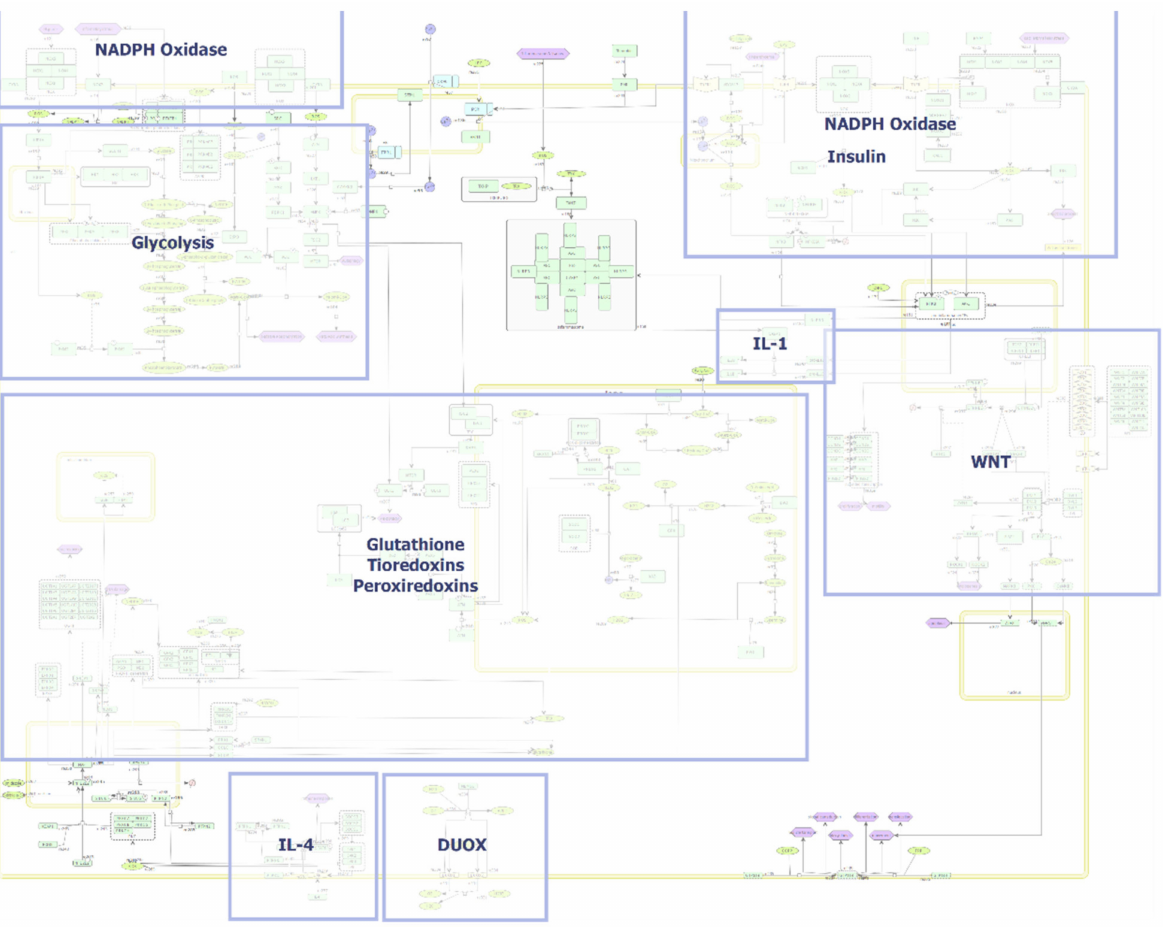
Figure 6. Redox signalling map grouped according to signalling process. Interacting species are indicated as nodes and their interactions as lines. Interactions can be “inhibition”, “positive influence”, “modulation”, “state transition”, and “transport”. Unclear interactions are visualized as dashed lines. (Green = proteins; bright green = simple molecules; purple = phenotypes; blue =